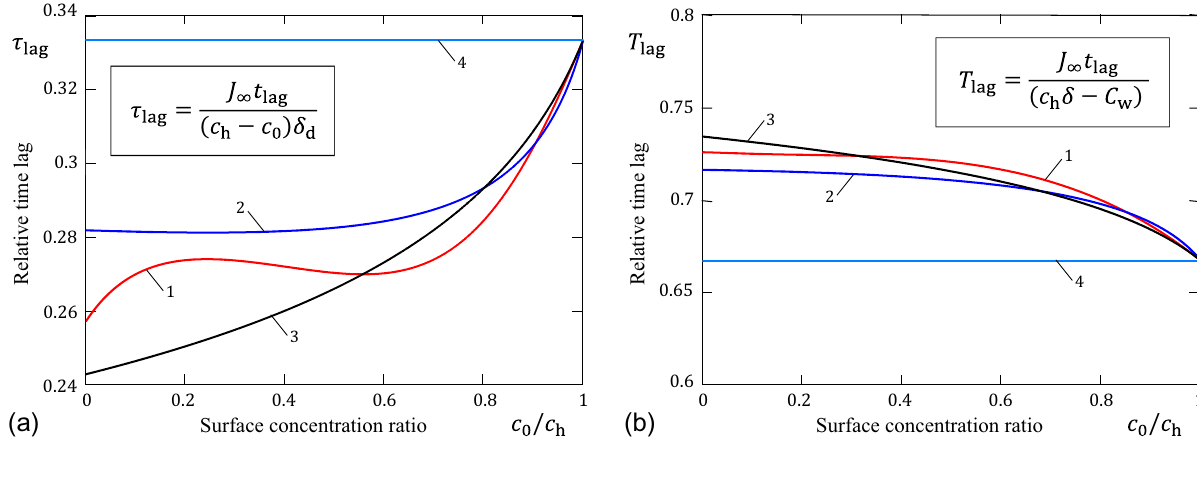
Figure 4. Time lag for stratum corneum relative to the SC dry ( a ) and wet ( b ) bases. Curves 1, 2, and 3 correspond to formulas (1), (2), and (3), respectively. The straight line (curve 4) represents the constant diffusivity